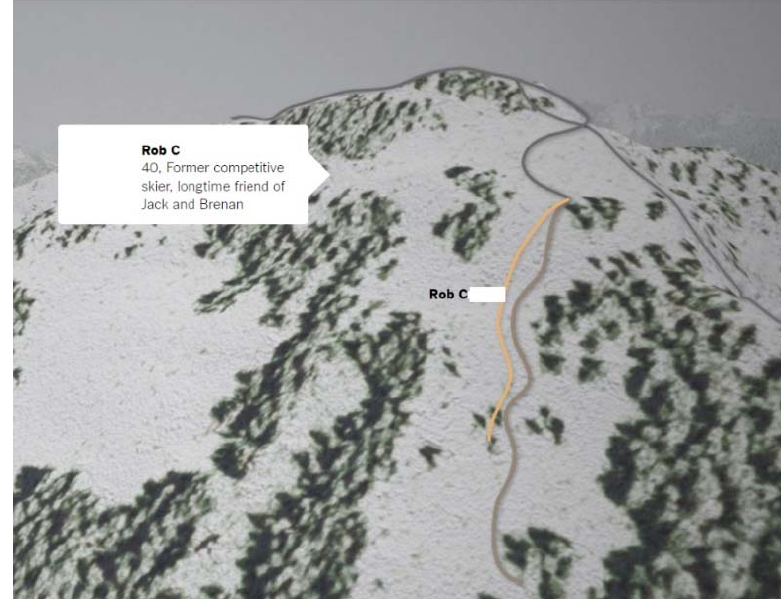
Figure 4. Graphic animation showing the routes taken by the different skiers.